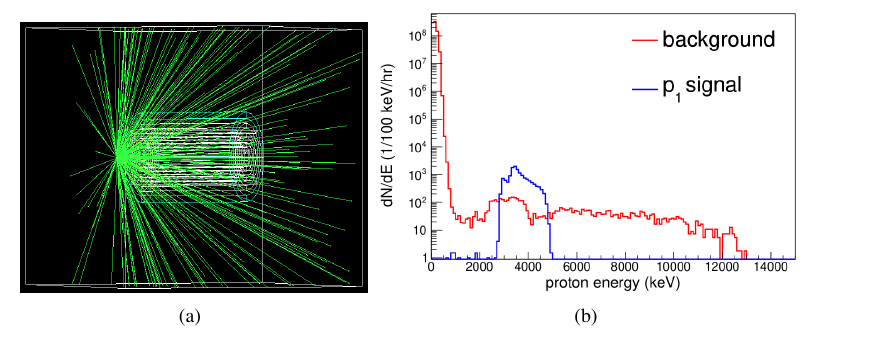
Figure 4. (a) A graphical illustration of Geant4 simulation of the detection setup where gamma rays are being bombarded on the detector. (b) Simulated background for proton energy of 3.6 MeV, compared to the expected yields from the 26 Al( n , p 1 )